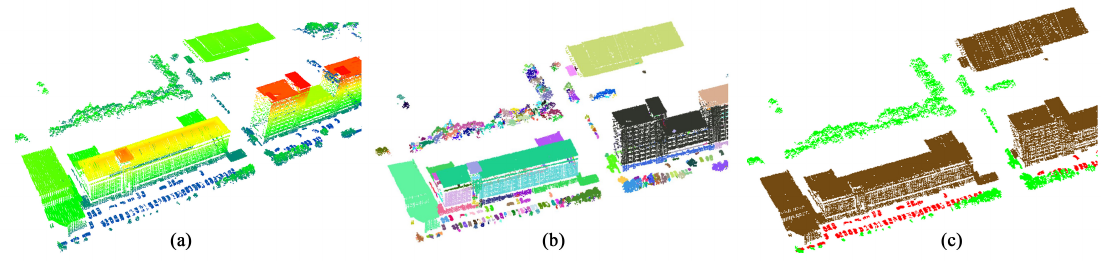
Figure 3. Coarse-grained cluster generation using the DBSCAN algorithm. ( a ) The raw point clouds. ( b ) The clustering results after using DBSCAN. ( c ) The reference data. Please note that in ( a ), the point clouds are colored by elevation. Different colors in ( b ) represent different clusters. A few colors have been reused, as a result, different disjoint clusters may share the same color. The semantic colors in ( c ) comply with the color code, i.e., green = trees, brown = buildings, and red =